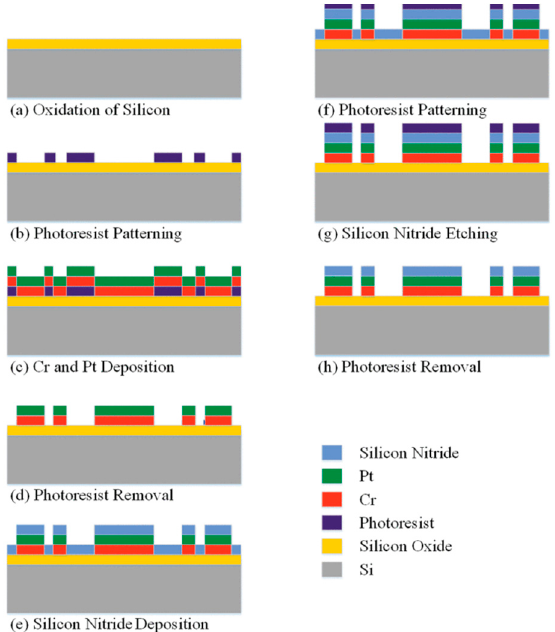
Figure 3. Batch fabrication process of the four-electrode conductivity sensor.